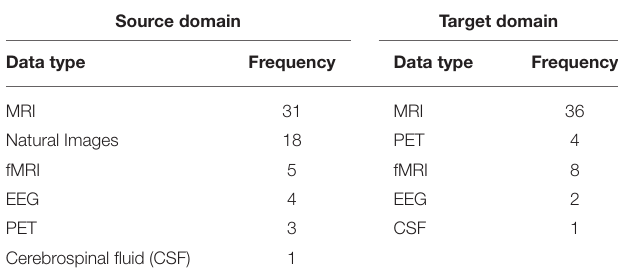
TABLE 1 | Frequency of datasets in source and target domains. TABLE 2 | Data types for source and target